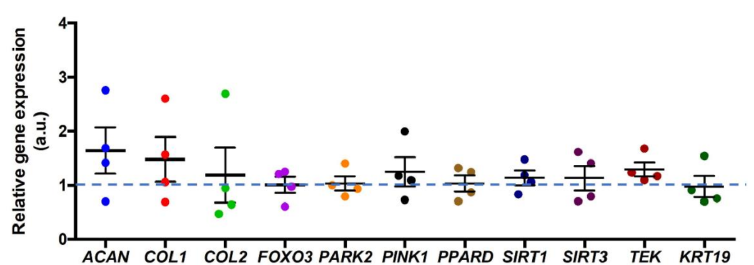
Figure 4. Relative gene expression of primary NPCs after PPAR δ agonist exposure after eight days of culture normalized to vehicle (DMSO) control (assigned to 1.0). ACAN stands for aggrecan, COL1 represents collagen type I, COL2 stands for collagen type II, FOXO3 stands for Forkhead Box O3, PARK2 stands for Parkin RBR E3 Ubiquitin Protein Ligase, PINK1 stands for Phosphatase and tensin homolog deleted on chromosome ten (PTEN)-induced putative kinase 1, PPARD stands for peroxisome proliferator-activated receptor delta, SIRT1 stands for silent mating type informa- tion regulation 2 homolog 1, SIRT3 stands for silent mating type information regulation 2 ho- molog 3, TEK stands for TEK receptor tyrosine kinase (Tie2), and KRT19 stands for Keratin 19; “a.u.” refers to arbitrary units; n = 4 donors, Mann–Whitney U test. Lines represent means ± standard deviation